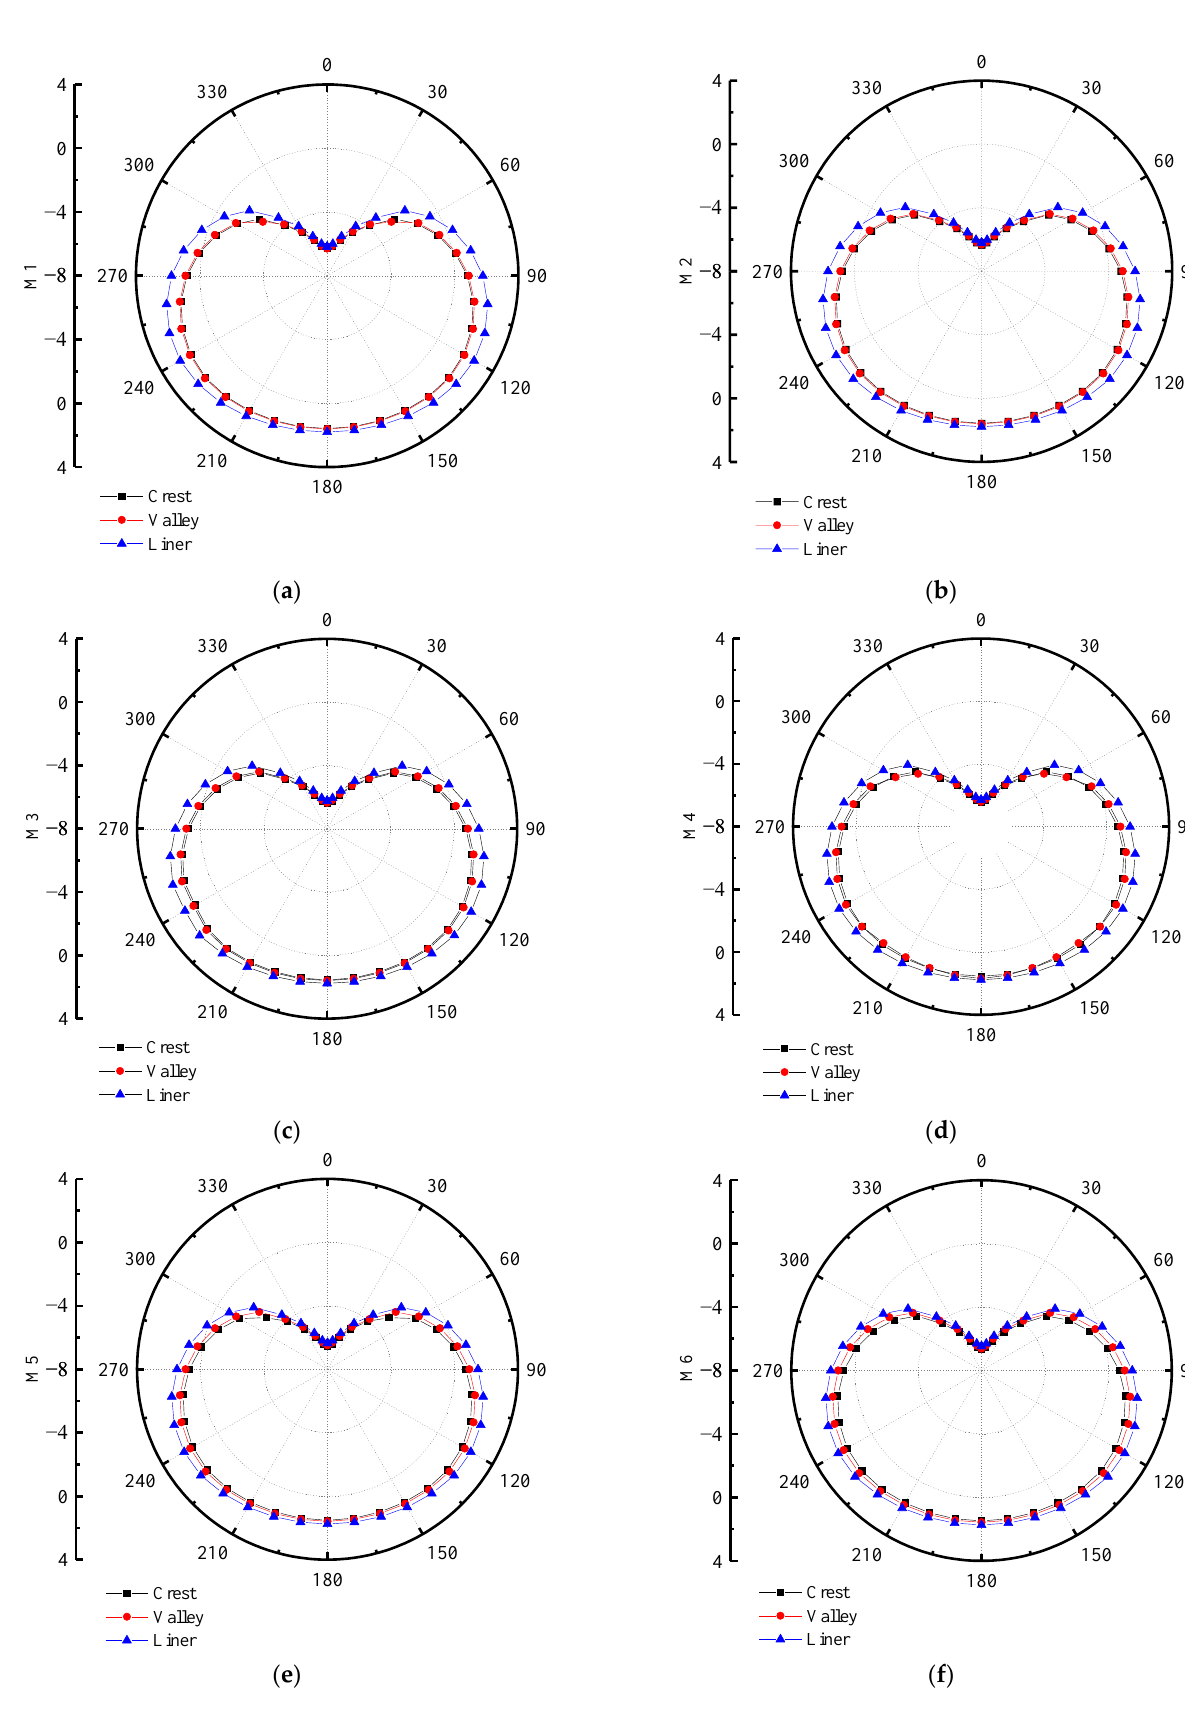
Figure 22. Radial displacement of pipes with various wall thicknesses. ( a ) M1; ( b ) M2; ( c ) M3; ( d ) M4; ( e ) M5; ( f ) M6.